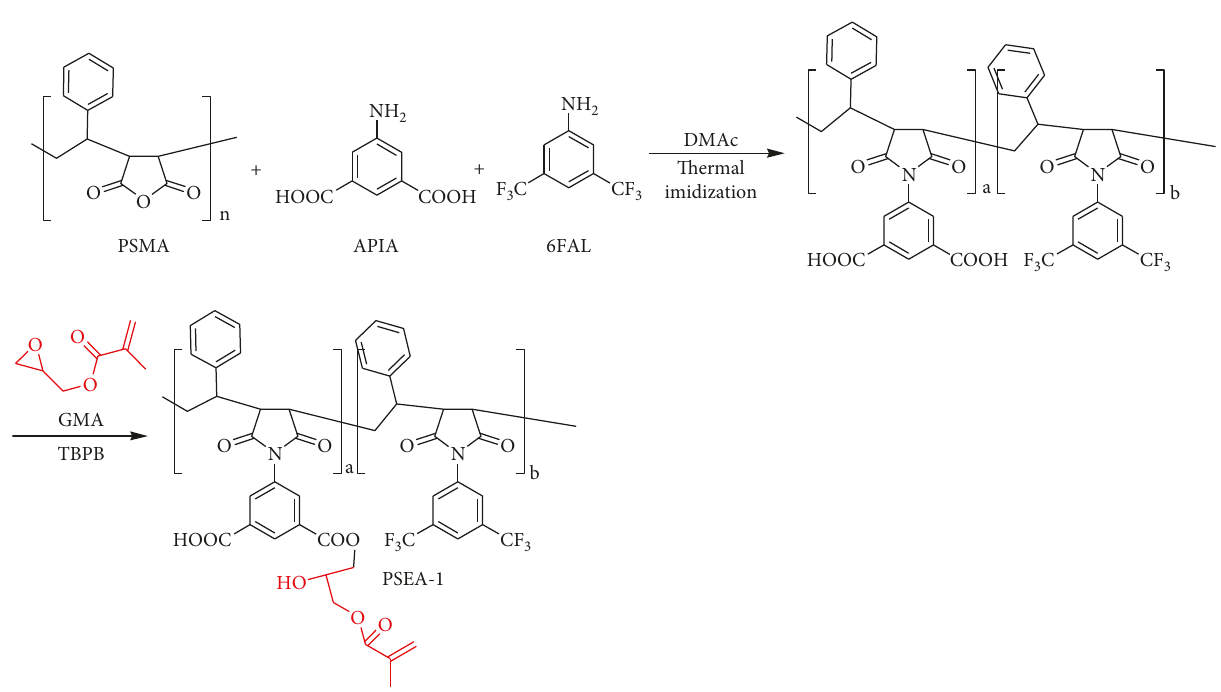
Figure 4: Synthetic scheme of methacrylate-type side-chain